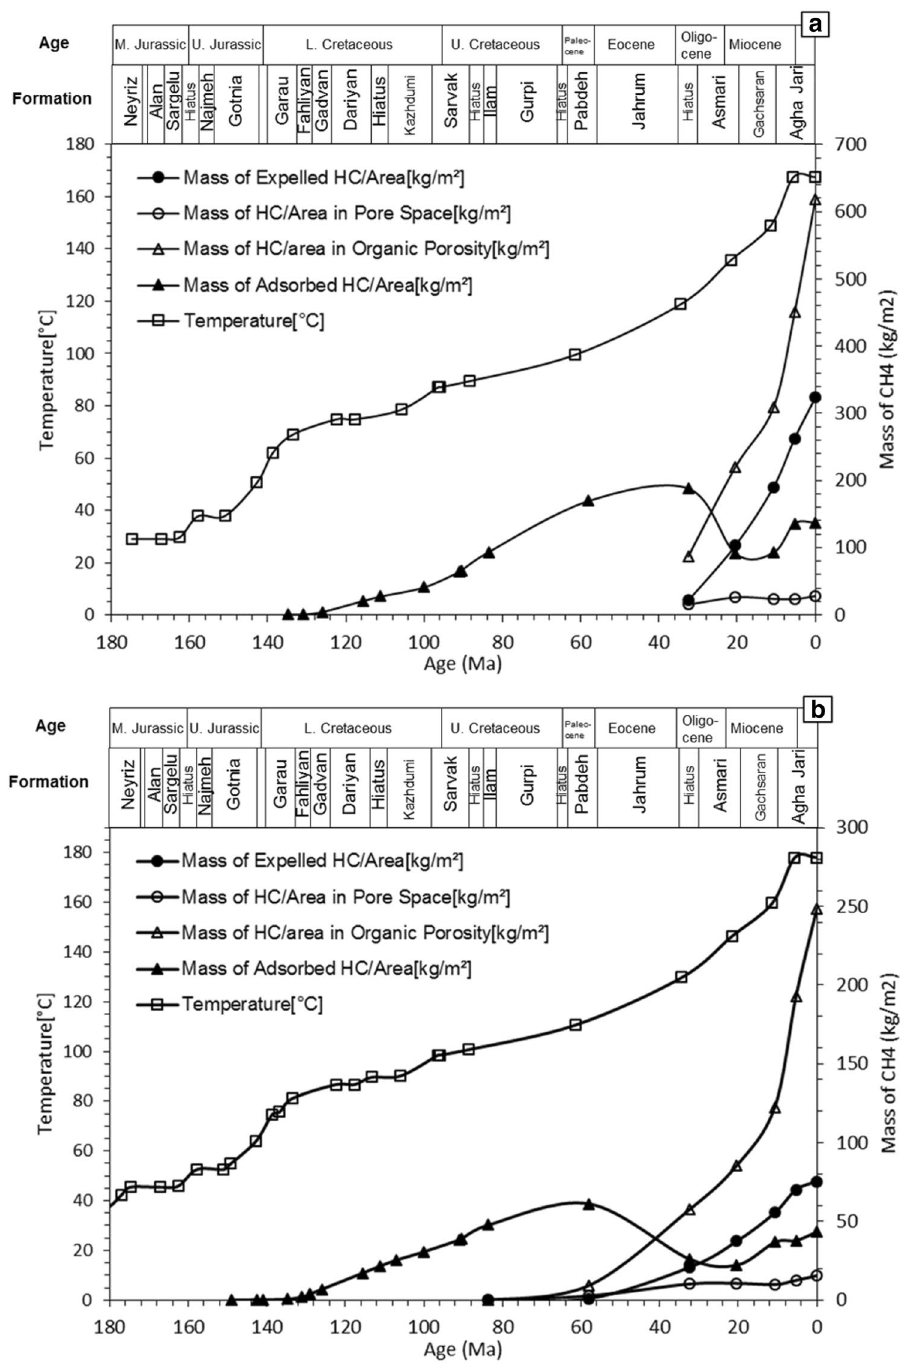
Fig. 17 Retained and expelled methane in the Sargelu ( a ) and Neyriz ( b ) source rocks in Well B through geological